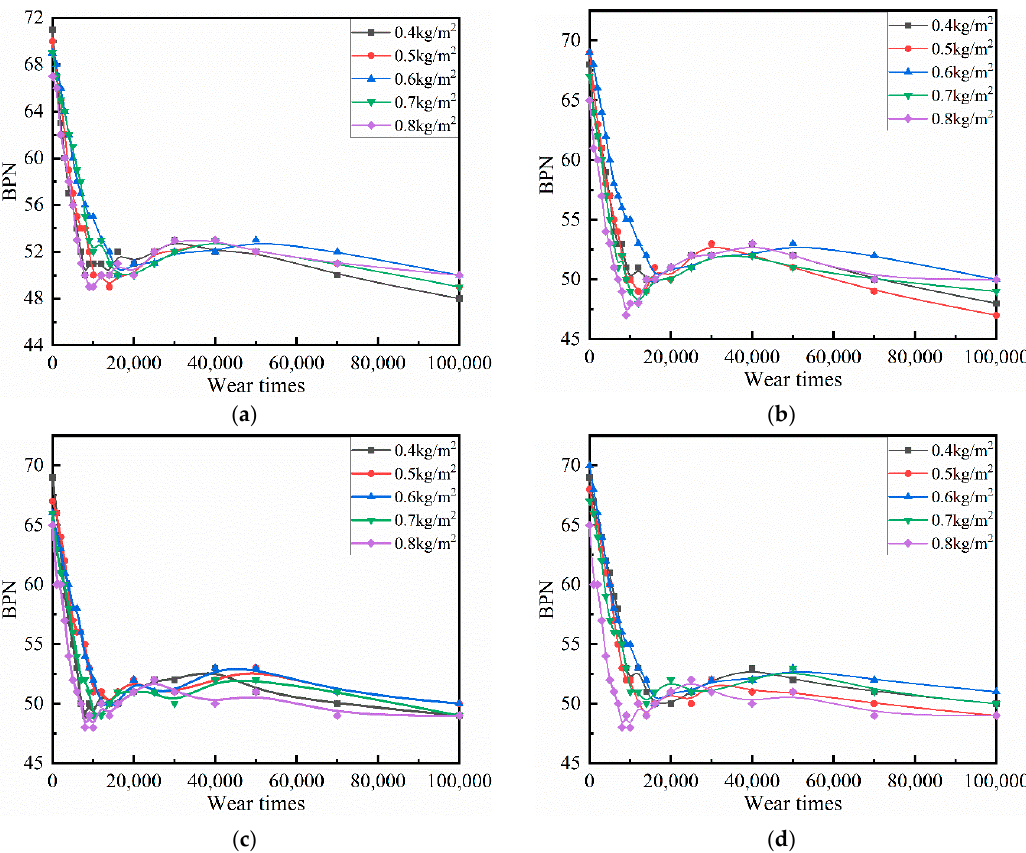
Figure 18. Skid resistance performance of di ff erent fog seals: ( a ) HPFA; ( b ) SBS-modified emulsified asphalt; ( c ) common fog seal; ( d ) BE-4 emulsified asphalt.